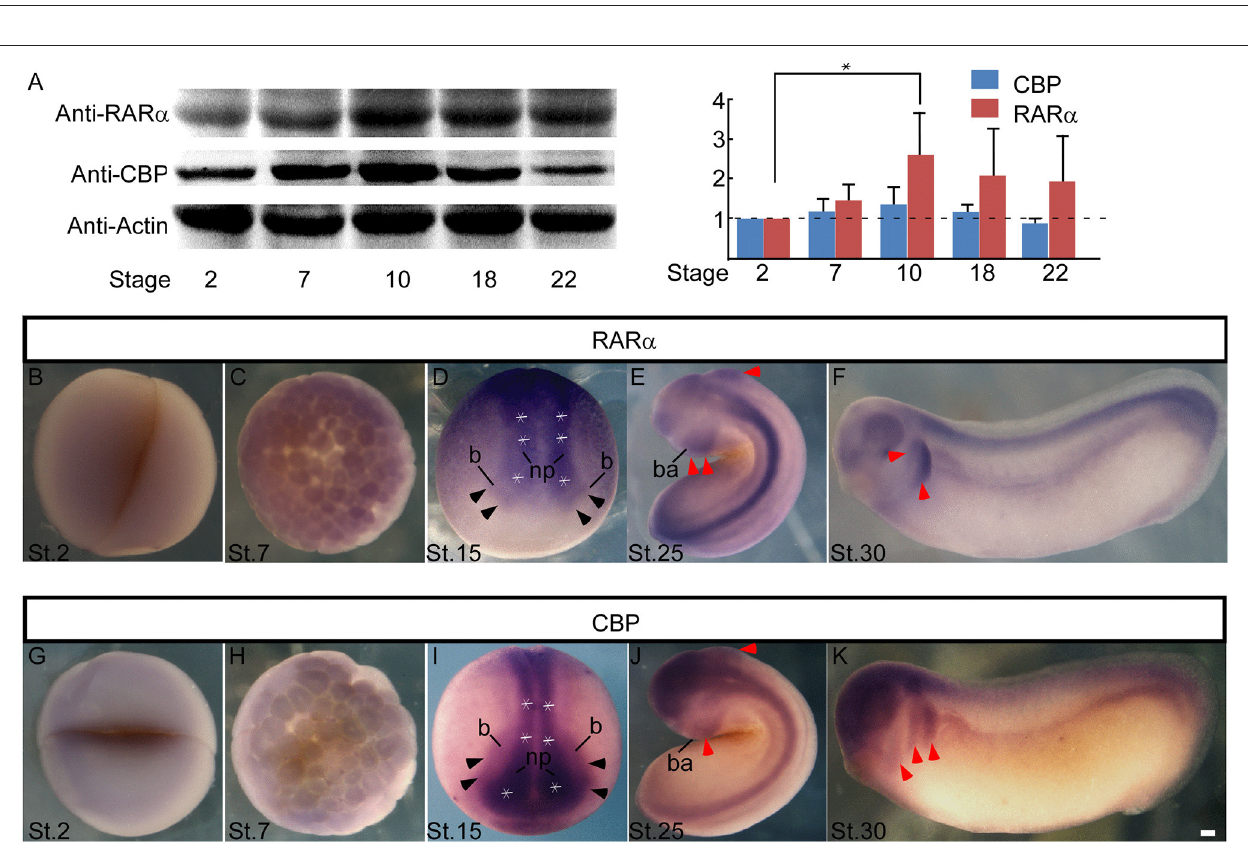
FIGURE 2 | RAR α and CBP expression in presumptive neural crest in Xenopus Laevis . (A) Developmental expression of the RAR α and CBP proteins in Xenopus laevis . β -actin was used as an internal control. Statistics revealed the ratio of protein levels relative to stage 2. RAR α (B) and CBP (G) are maternally expressed at the animal hemisphere, and the expression intensity increases at stage 7 (C,H) . At the neural plate stage (stage 15), RAR α (D) and CBP (I) appear in the central neural plate (* white asterisk means neural plate) and anterior neural plate border (black arrowhead). At stage 25 (E) and stage 30 (F) , RAR α is in the neural tube and branchial arch (red arrowhead). CBP has a similar expression pattern in the branchial arch (red arrowhead) and neural tube at stage 25 (J) and stage 30 (K) . np, neural plate; b, neural plate border region; ba, branchial arch. Scale bar: 100 µ